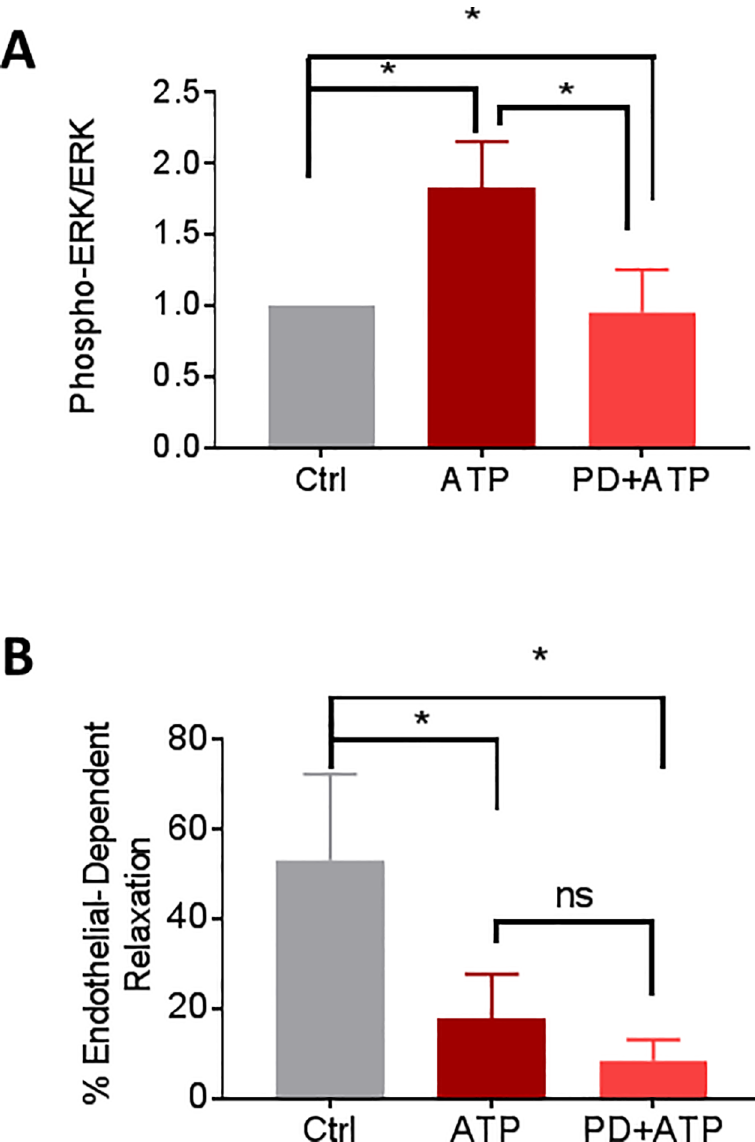
Fig 6. PD 98059 decreasesthe phosphorylation of ERK in HSVEC, but does not restore ATP-induced decreasein endothelial function in RA. A. HSVEC were untreated(Ctrl), treated with ATP (2 mM), or ATP with 10 μ M PD 98059 (PD+ATP) for 20 min and phosphop44/42MAPK (P-ERK1/2) and total p44/42(ERK1/ 2) proteins were quantitated with immunoblotting (adjustedto the loadingcontrol GAPDH). Cumulativedata showingthe phosphorylation (fold) of p ERK1/2 MAPK, * p < 0.05, N = 3, pairedt-test. B. RA rings were untreated (Ctrl), treated with eATP (20 mM, ATP) or ATP with 20 μ M PD 98059(PD+ATP) for 1hr, then suspendedin the muscle bath and the vessels were pre-contracted with phenylephrine(5 x 10 − 7 M) and treated with carbachol (5 x 10 − 7 M). N = 5 segments from different rats, * p < 0.05,ns = nonsignificant, (1 way